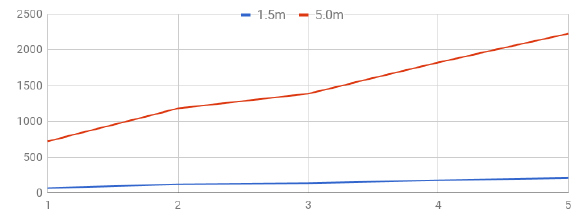
Figure 4. Time (in sec.) for calculating polynomial models in a neighborhood of 1.5 (blue) and 5 m (red) of orders 1-5 (on the horizontal axis) for the dataset in fig. 10.